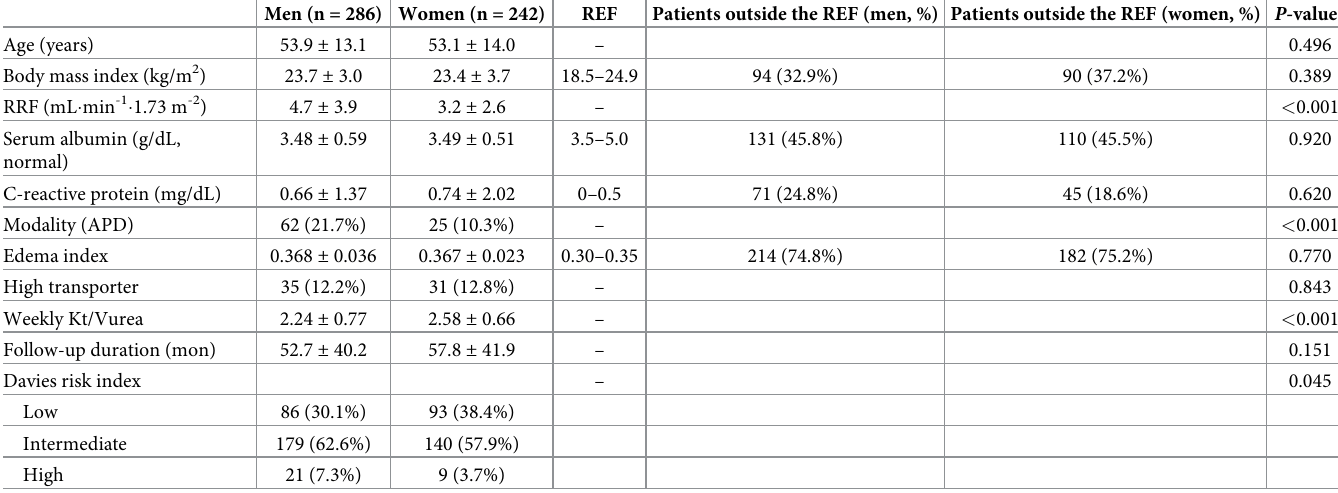
Table 1. Clinical characteristics of participants at the time of peritoneal dialysis